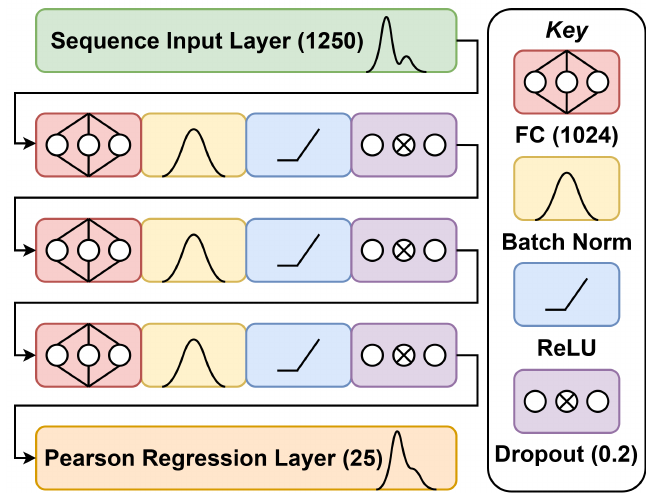
Figure 3. Waveform neural network architecture. FC refers to a fully connected layer. Table 1. Results of various neural network architectures for waveform regression. Row 1 corresponds to the final model